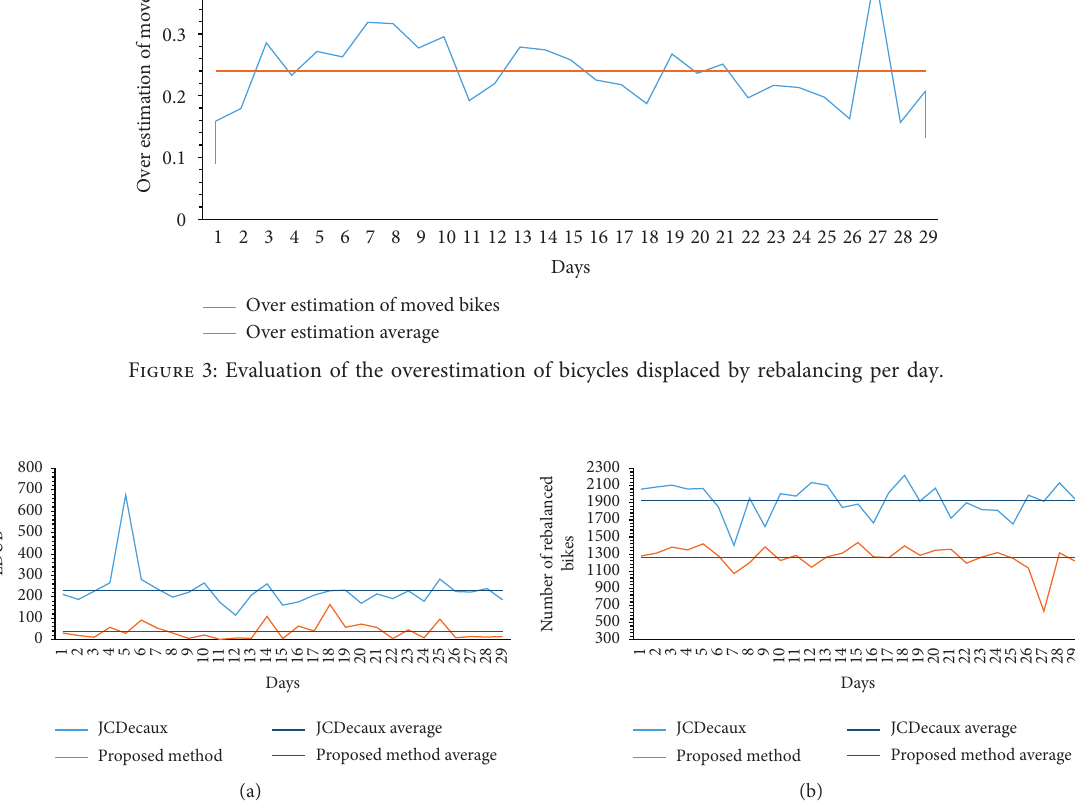
Figure 4: (a) Estimated LDUB after rebalancing according to the proposed method and according to the operator. (b) Number of bicycles displaced according to the rebalancing of the proposed method and according to the operator ʼ s